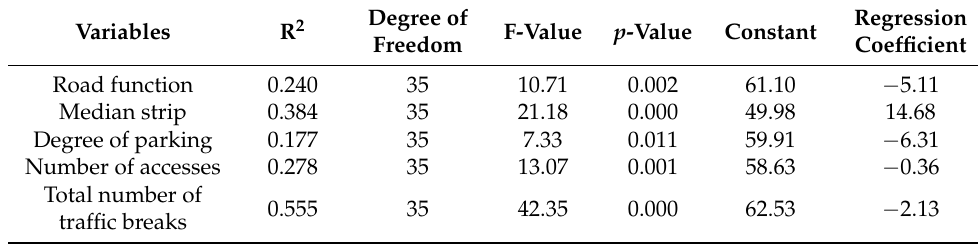
Table 10. Regression analysis results for selected variables.